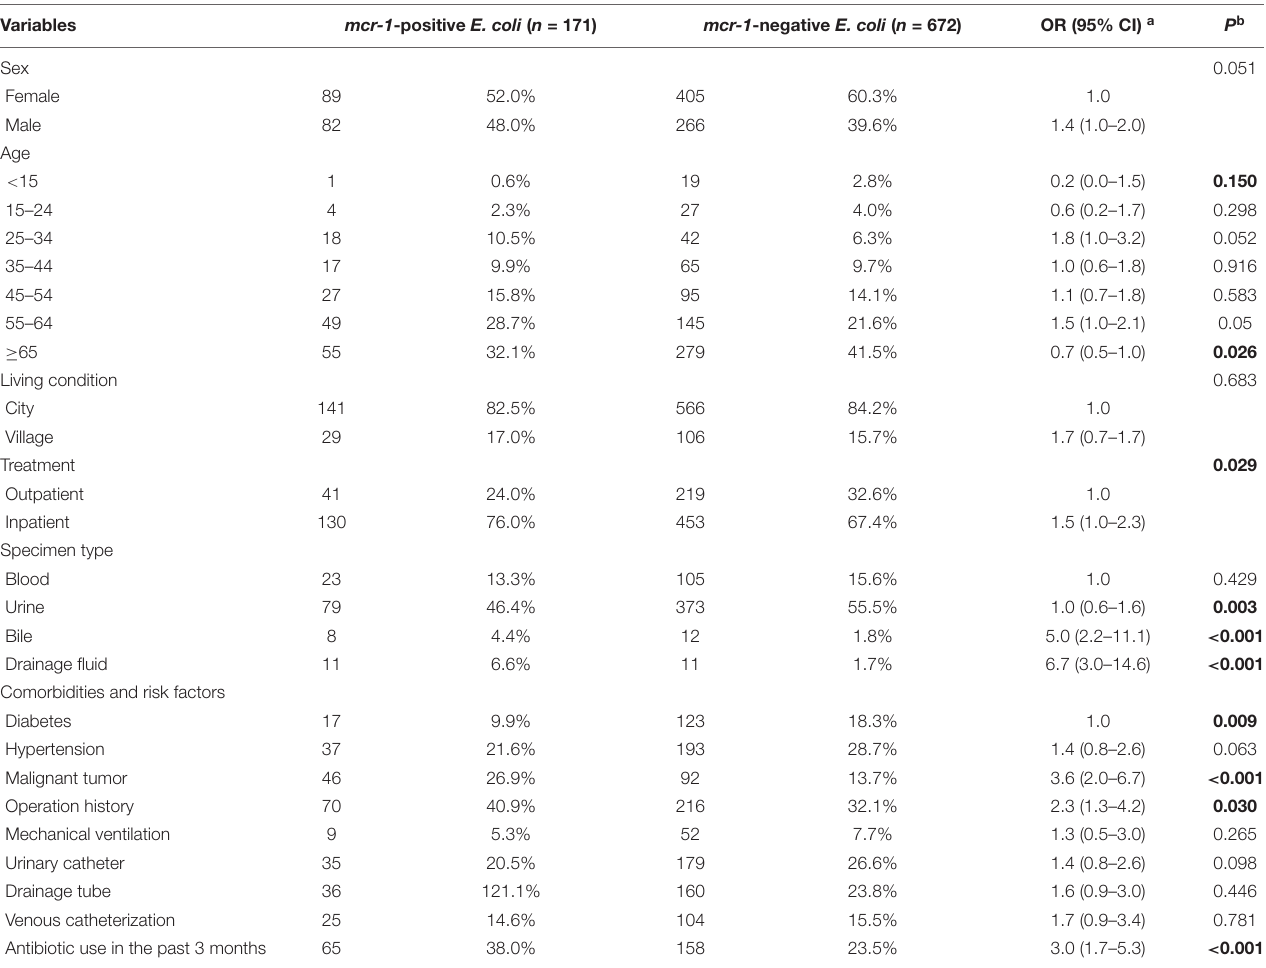
TABLE 1 | Analysis of risk factors associated with mcr-1 -positive E. coli ( n = 843).